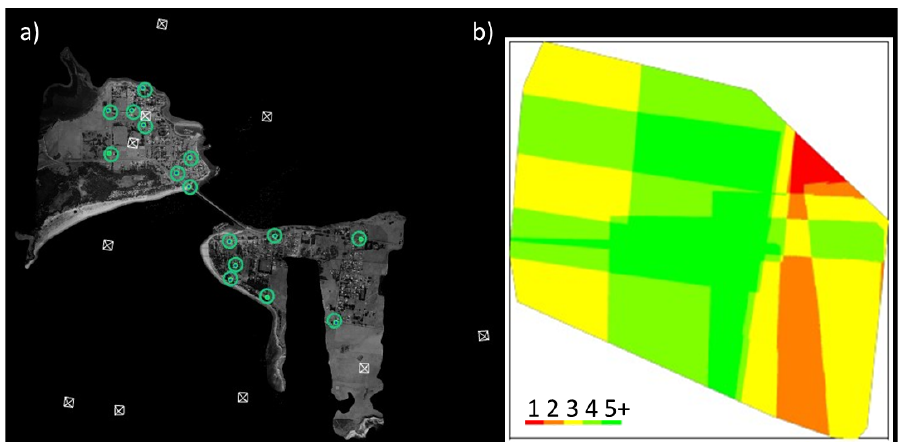
Figure 2. Areas covered by triangle meshes for the historical model ( a ) and colour-coded number of overlapping images ( b ). White crosses represent photographic locations while green circles show individual GCPs added to model.